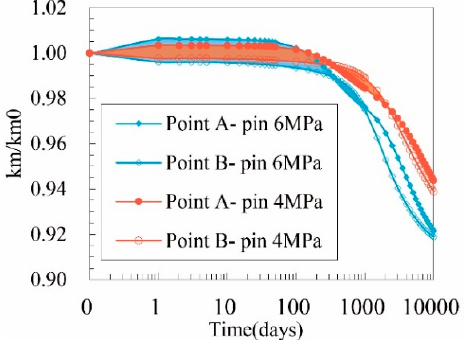
Figure 15. Evolution of matrix permeability at different points under the 4 MPa and 6 MPa injection pressure.